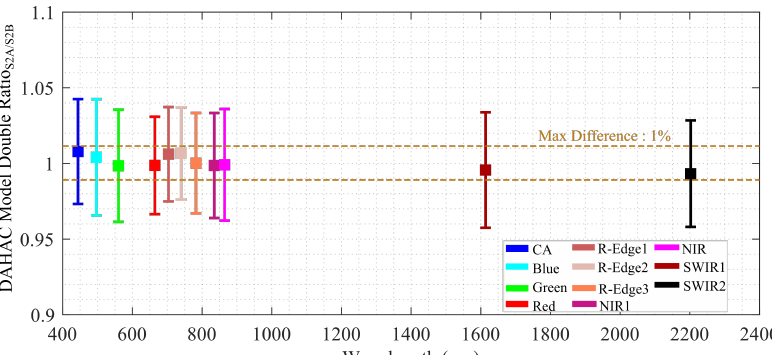
Figure 28. Double ratio between S2A and S2B. Orange dotted lines show a maximum 1% differences between S2A and